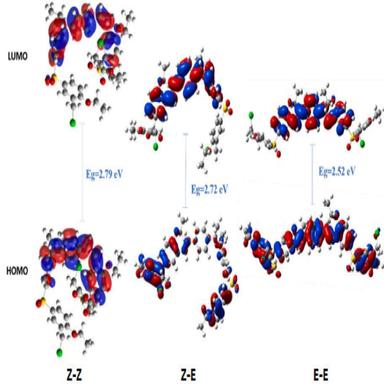
Distribution of the molecular frontier orbitals (HOMOs and LUMOs) of M-DSB isomers obtained from the TD-DFT (The bleu region shows the charge increasing parts and the red region points to the charge decreasing parts).